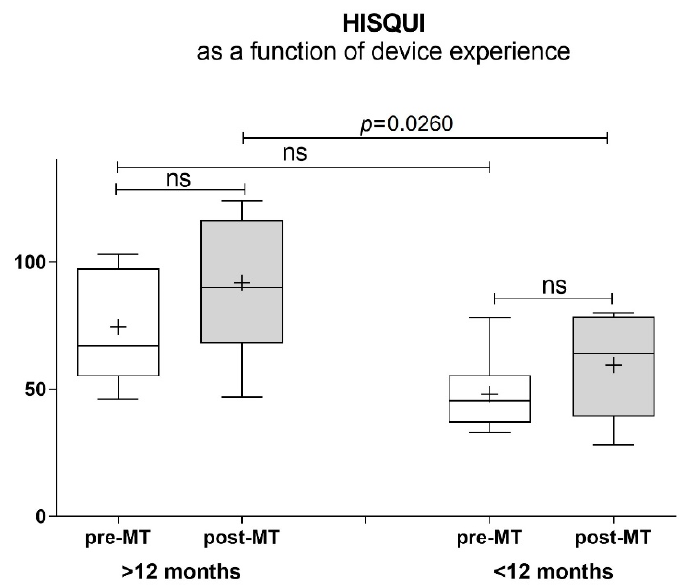
Figure 3. Hearing Implant Sound Quality Index as a function of device experience.